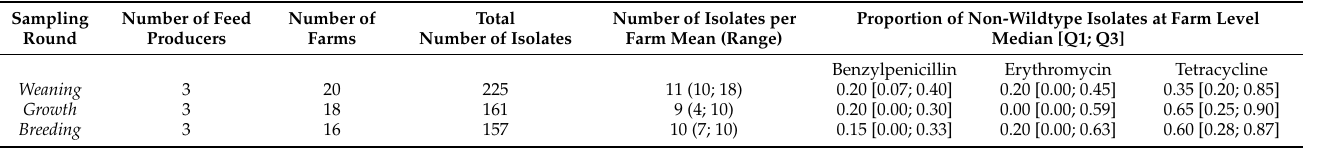
Table 1. Staphylococcus delphini isolates from Danish mink farms collected during three sampling rounds from 2018–2019.